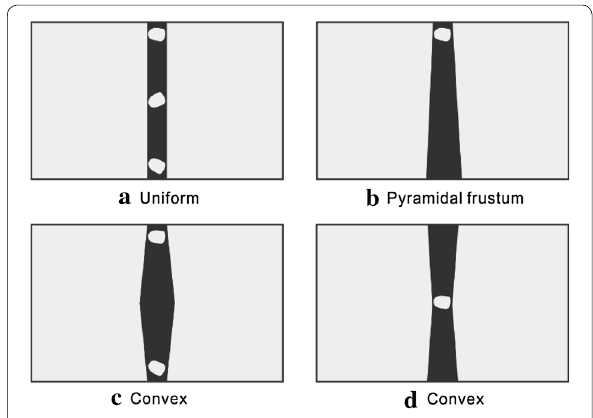
Fig. 11 Possible crack geometry in specimens (Roig-Flores et al.